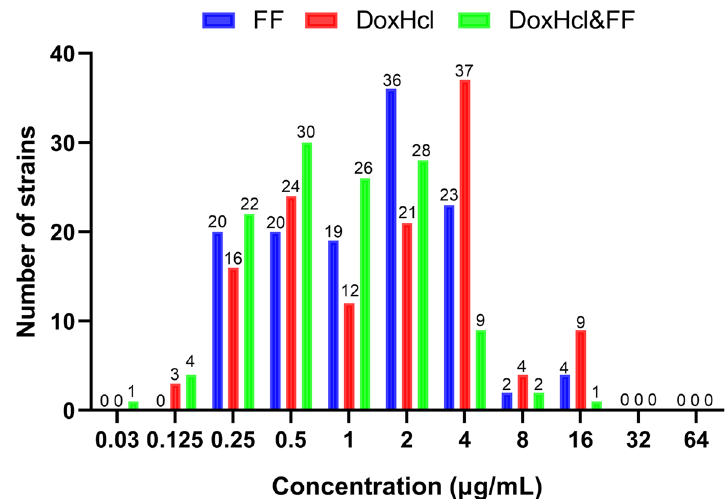
Fig. 1 MICs of APP in response to FF (blue), DoxHcl (red) and DoxHcl&FF